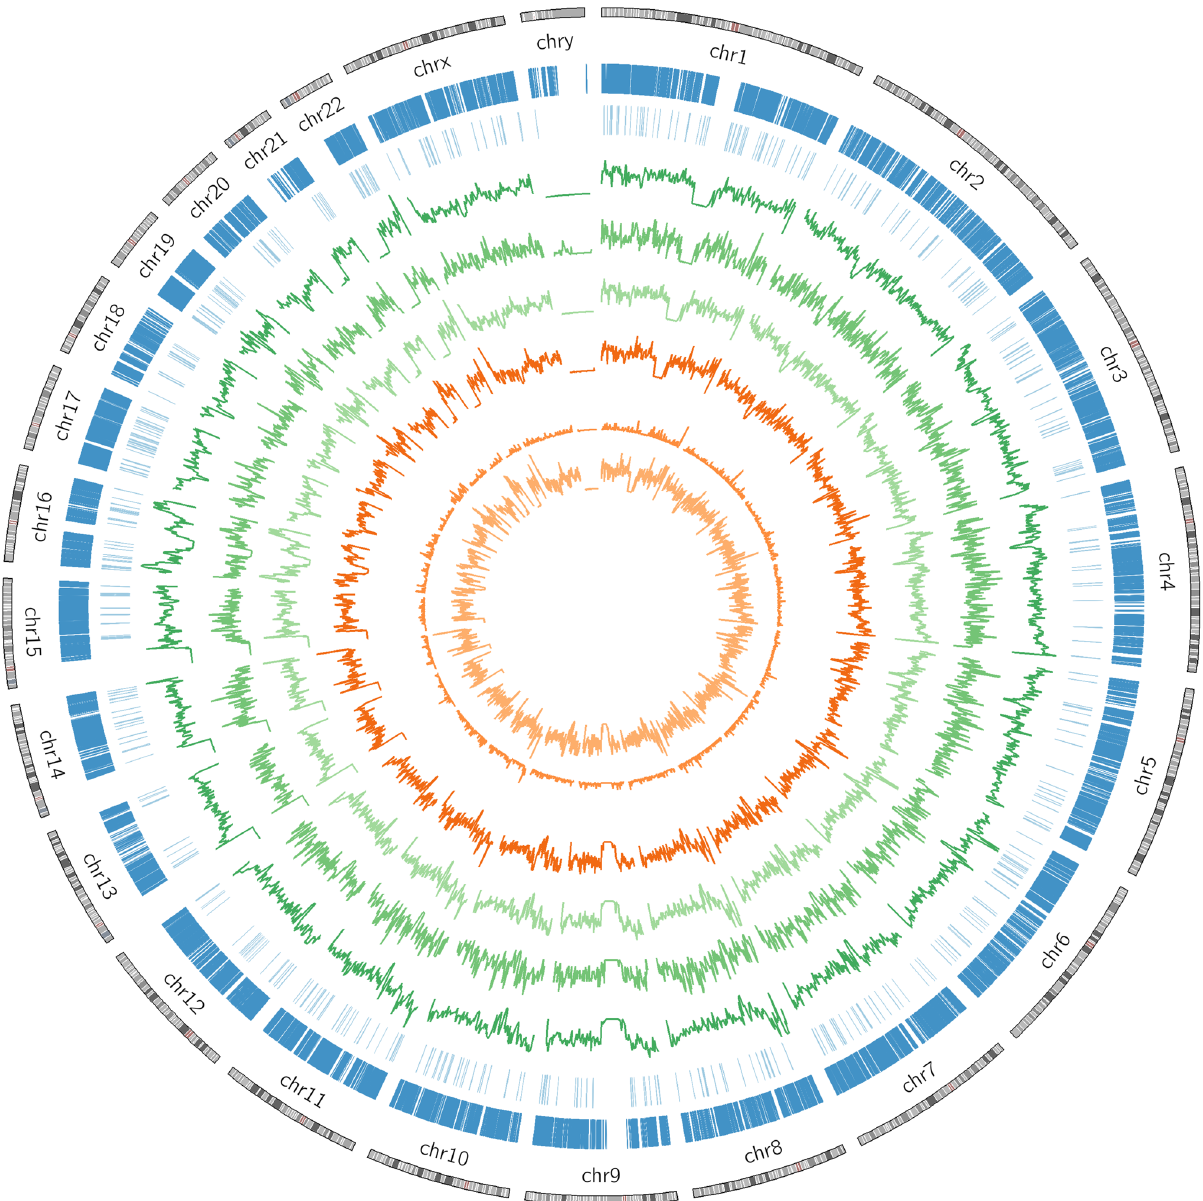
Fig 1. Schematic overview of “gold standard” variants in the simulated data set. Moving from outer to inner circle, the circles show chromosomes, genomicregionscovered in the exome experiments (dark blue), genomicregions in the panel regions (light blue), density of germline and somatic SNVs combined(dark green; maximum of scale at 3,000), density of somatic SNVs (green; maximum at 30), density of germline SNVs (light green; maximum at 3,000), density of germlineand somatic indels (dark orange; maximum at 300), density of somatic indels (orange;maximum at 30), and density of germlineindels(light orange; maximum at 300). Variant densitieswere computedin 1 Mb bins.